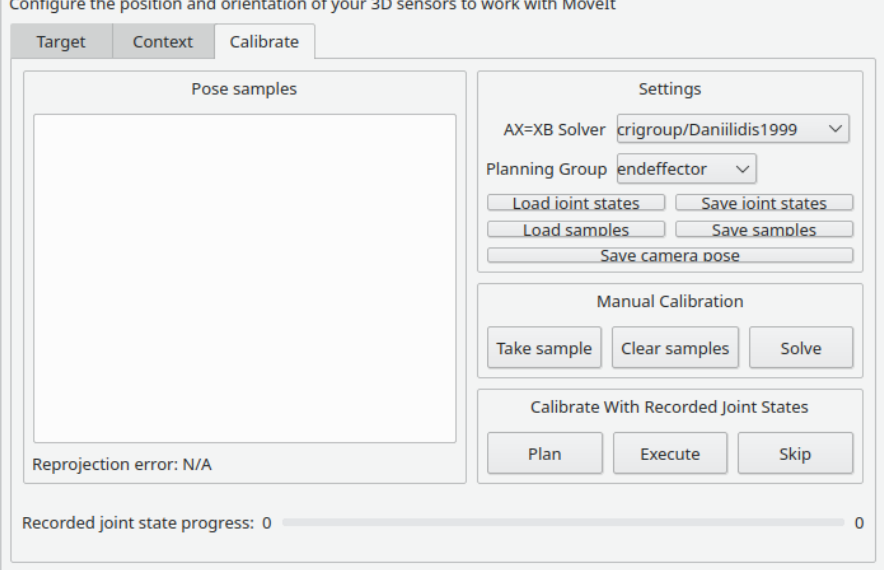
Figure 2. moveit_calibration UI inside RViz, where the user can acquire data using the “Take Sample” button and the estimation of parameters carries out automatically